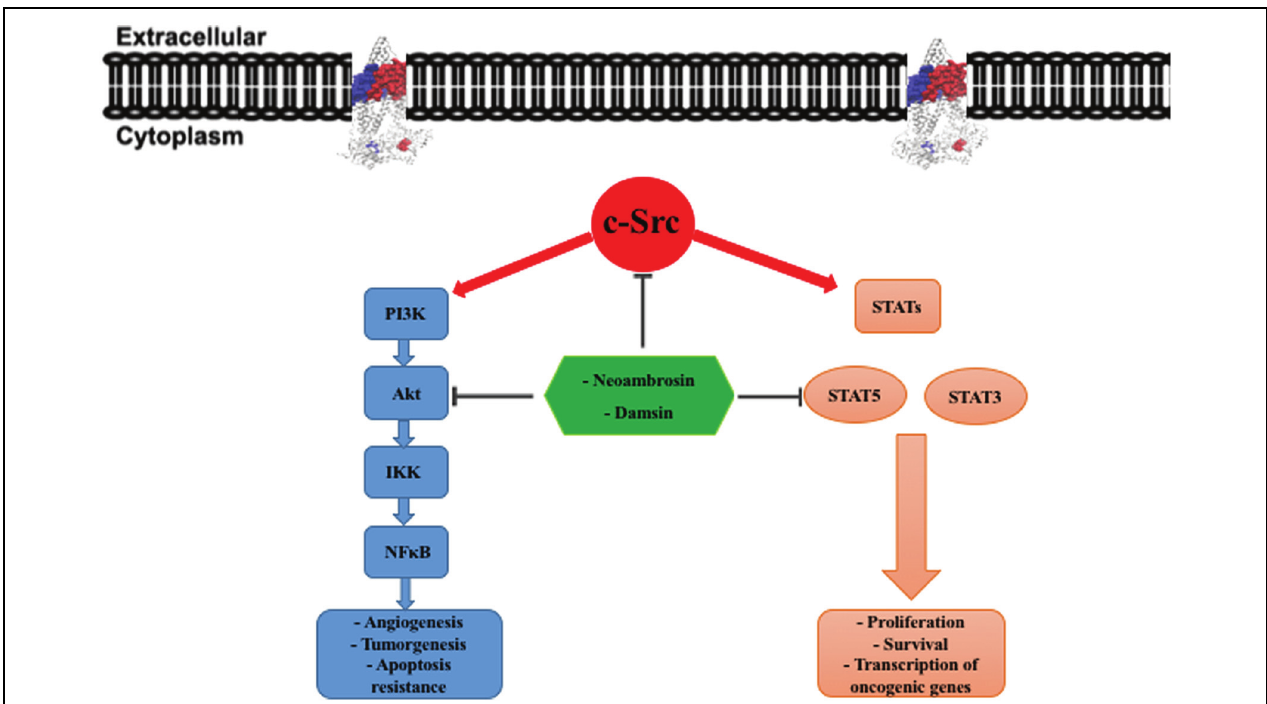
FIGURE 5 | c-Src downstream signaling pathways. In tumor cells, overexpression of c-Src leads to constitutive activation of PI3K/Akt and STATs (STAT3 and STAT5) pathways. This activation governing cancer development and progression. PI3K, phosphatidylinositol-3-kinase; IKK, I κ B kinase; NF κ B, nuclear factor kappa-light-chain-enhancer of activated B cells; STAT, signal transducers and activators of